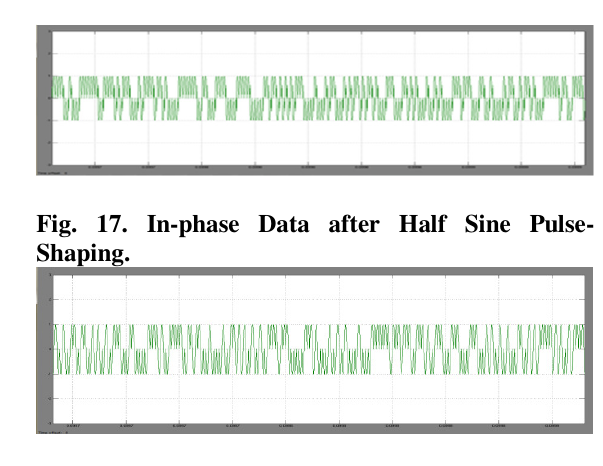
Fig. 18. Quadrature Data after Half Sine Pulse Shaping.